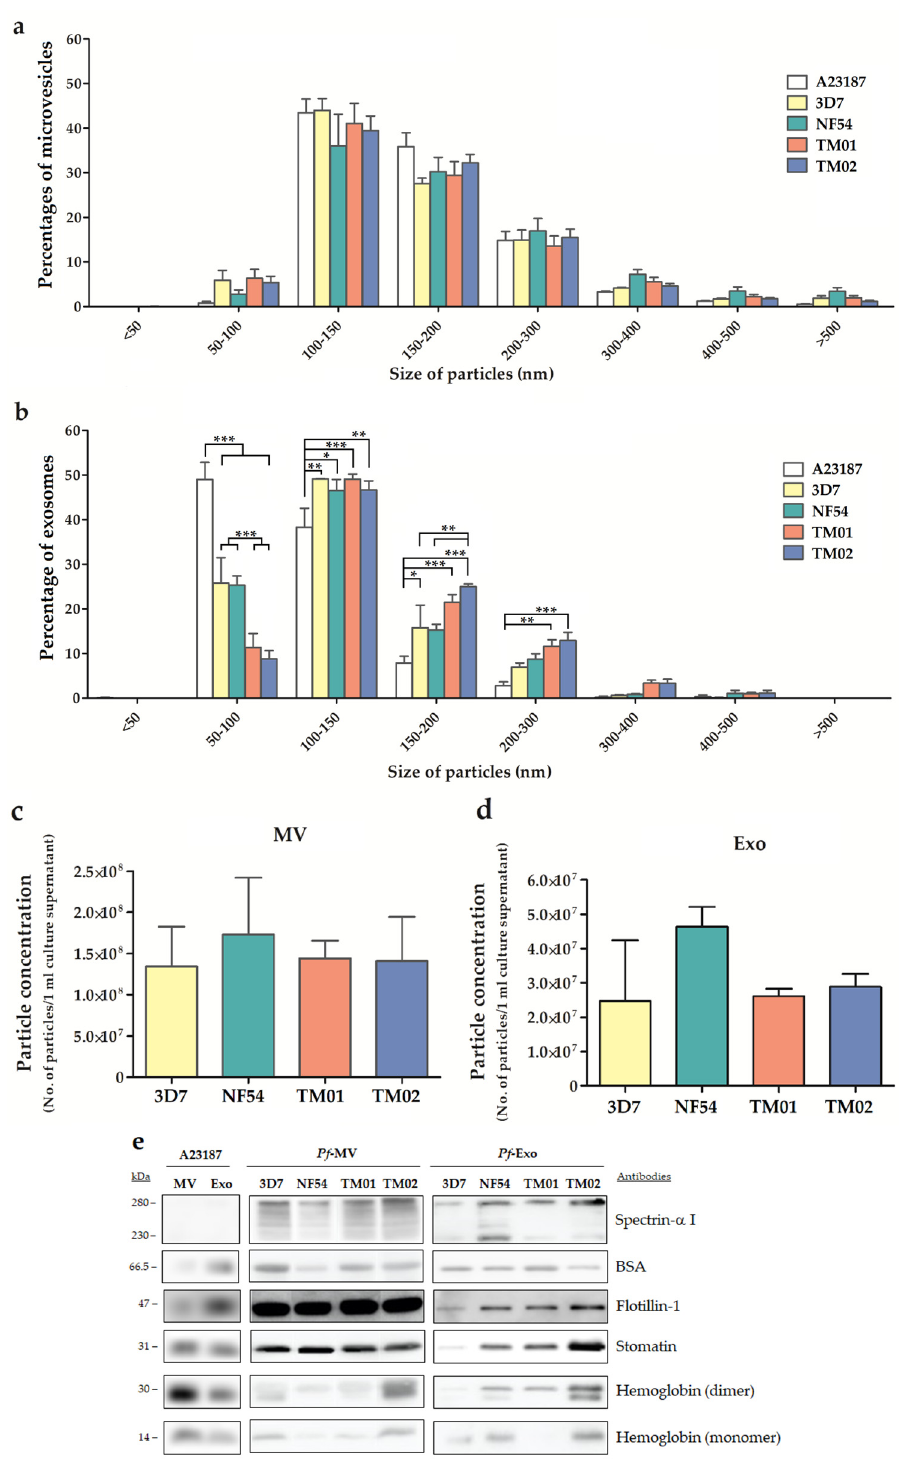
Figure 2. Characteristics of Pf -EVs derived from four P. falciparum strains (3D7, NF54, TM01, and TM02) and control EVs from A23187-activated RBCs. ( a – d ) NTA analysis. ( a ) Particle size